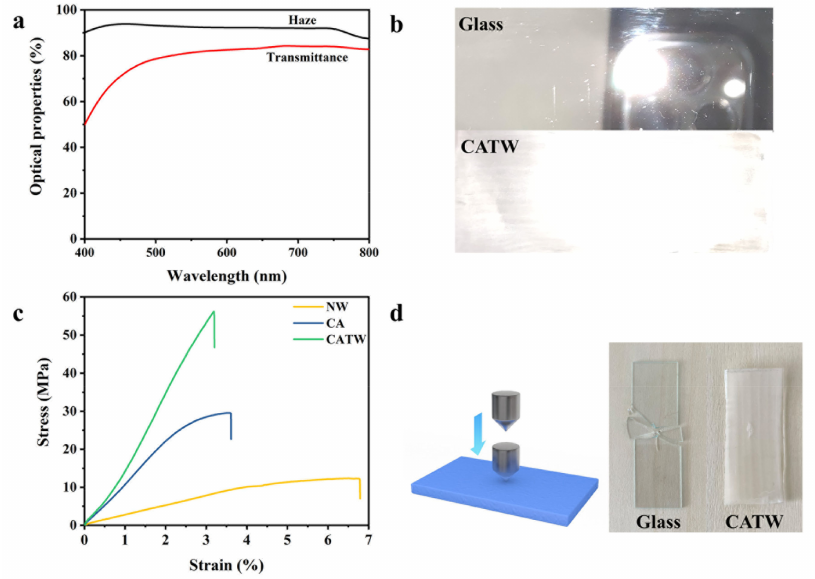
Figure 2. ( a ) Optical transmittance and haze profiles of CATW (1 mm). ( b ) Photograph of the glare effect of glass and CATW. ( c ) Stress–strain curves for NW, CA, and CATW. ( d ) Impact tests of glass and CATW: the glass shatters under a sudden impact ( left photo) and the CATW shows only a dent on the surface ( right